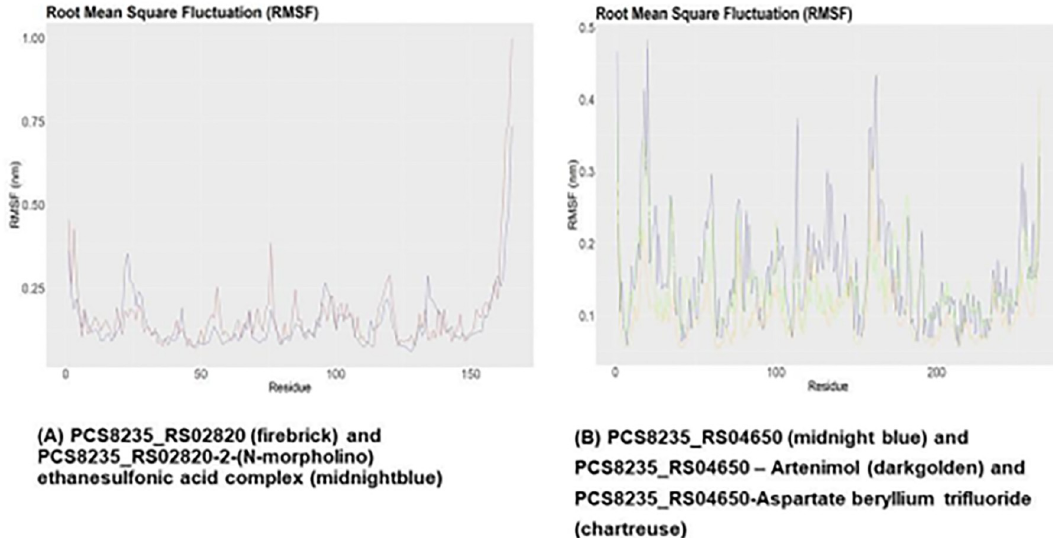
Fig 8. RMSF analysis of (A) PCS8235_RS02820 (brown) and PCS8235_RS02820-2-(N-morpholino) ethanesulfonic acid complex (blue) (B) PCS8235_RS04650 (blue) and PCS8235_RS04650 –Artenimol (golden) and PCS8235_RS04650-Aspartate beryllium trifluoride (green) at 100 ns.